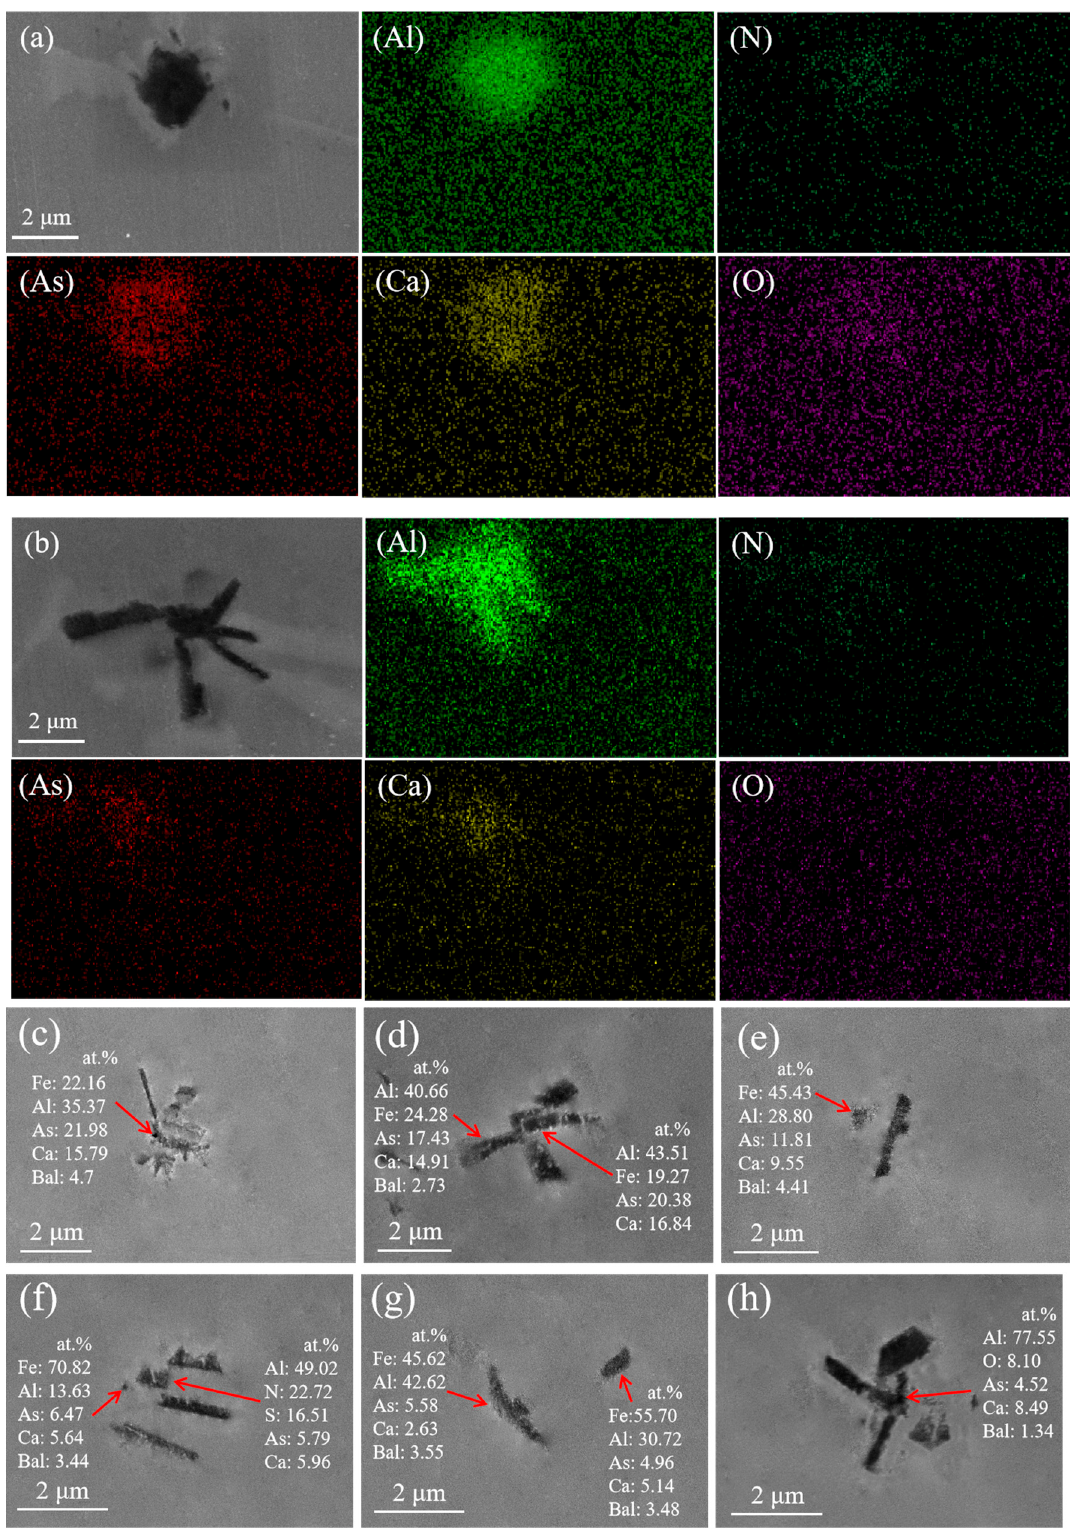
Figure 3. Arsenic inclusions and surface scan images. ( a , b ) Electron microscopy and morphology of inclusions. ( c − h ) Morphology and chemical composition of arsenic inclusions.